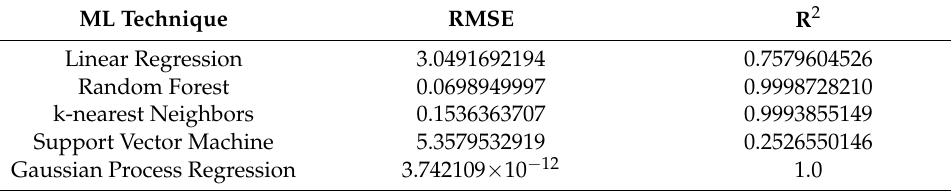
Table 10. Temperature